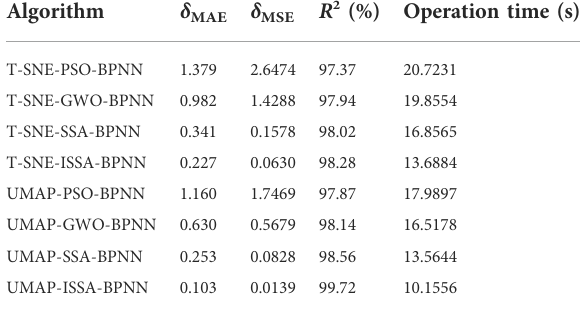
TABLE 4 Comparison results of inversion performance for BPNN and improved models. Algorithm